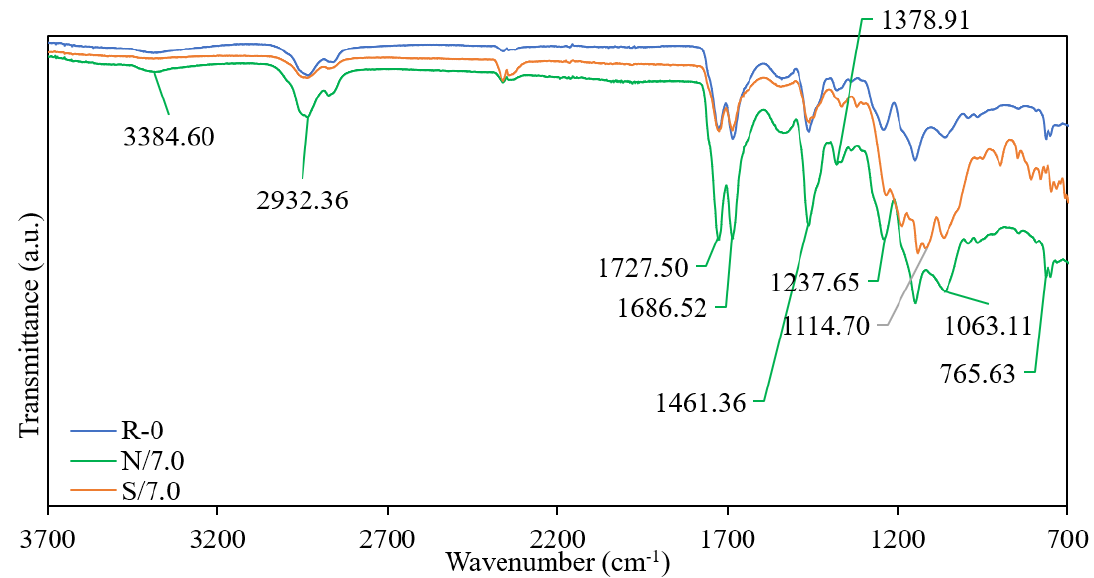
Figure 2. FTIR spectra of PU coating (R-0), PU coating blended with silica nanoparticles (N/7.0), and PU coating blended with silica nanoparticles and modified with silane (S/7.0).